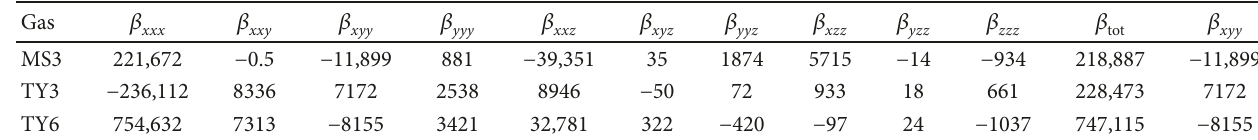
Table 8: Hyperpolarizabilities of MS3, TY3, and TY6 in the gas phase.